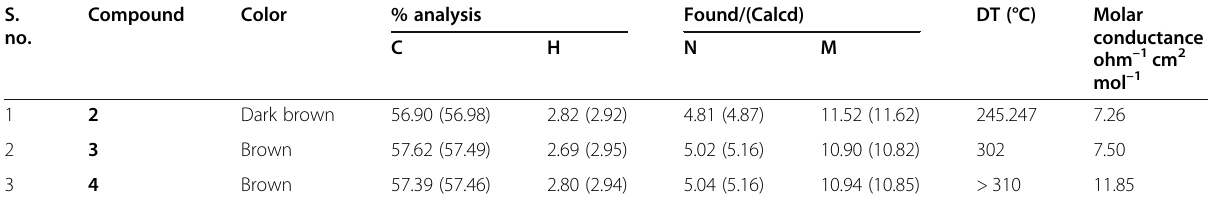
Table 1 Physical and analytical data of complexes 2, 3, and 4 S. no.